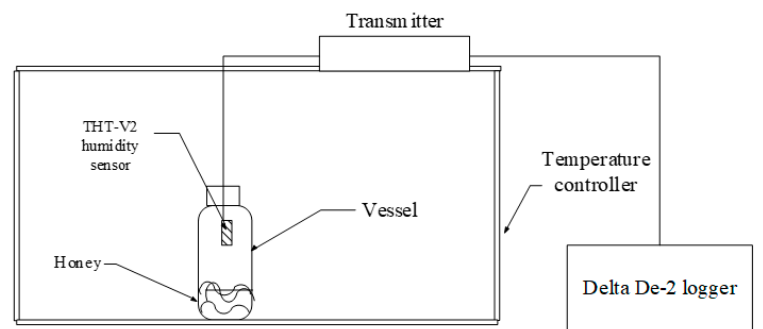
Figure 1. Diagram of the experimental set-up.